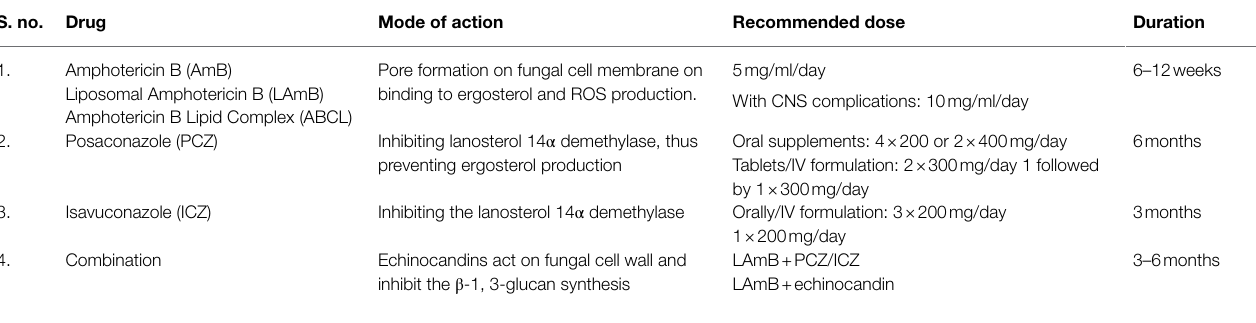
TABLE 2 | Recommended antifungal agents and